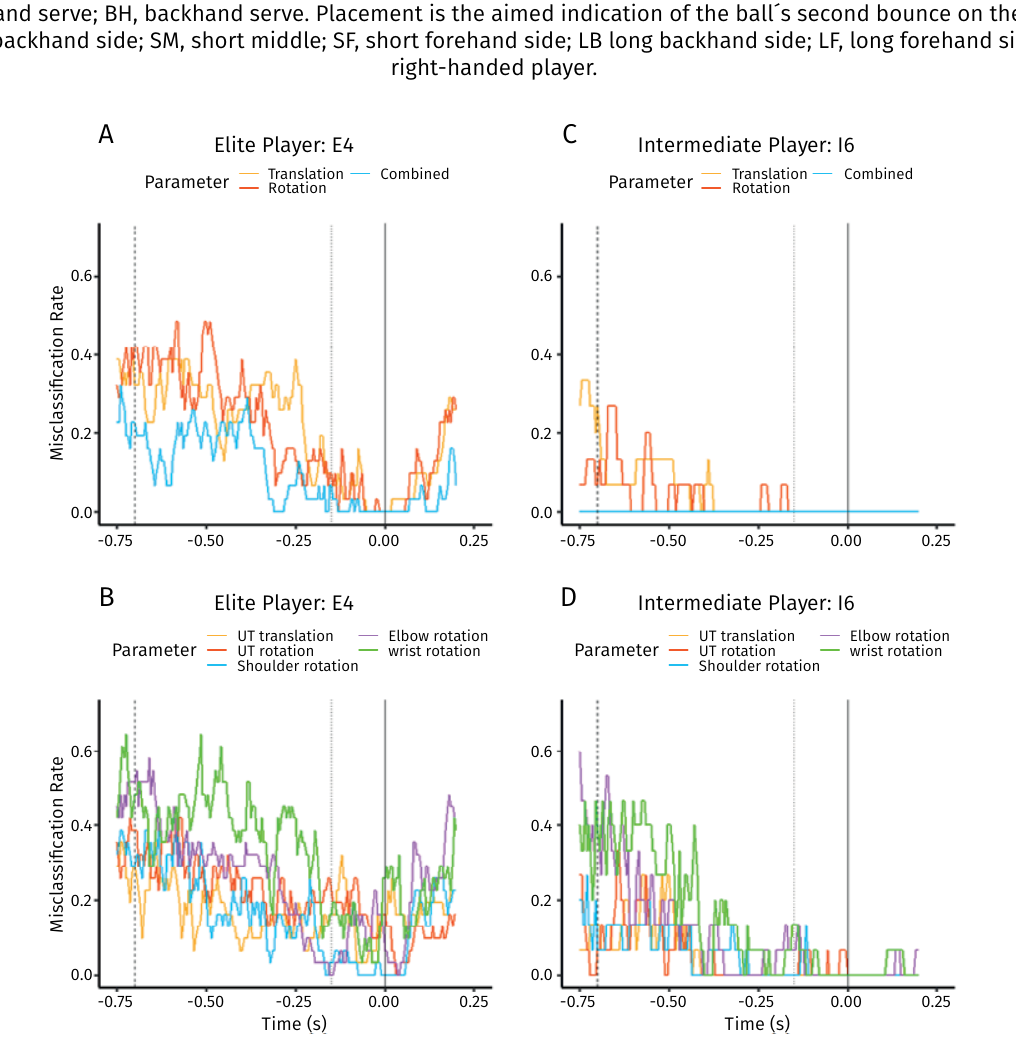
Misclassification rates determined by the linear discriminant analysis with the racket kinematics and upper trunk and racket arm movements for elite player E4 (A and B, respectively) and intermediate player I6 (C and D, respectively). UT, upper trunk. The vertical lines indicate the beginnings of the early